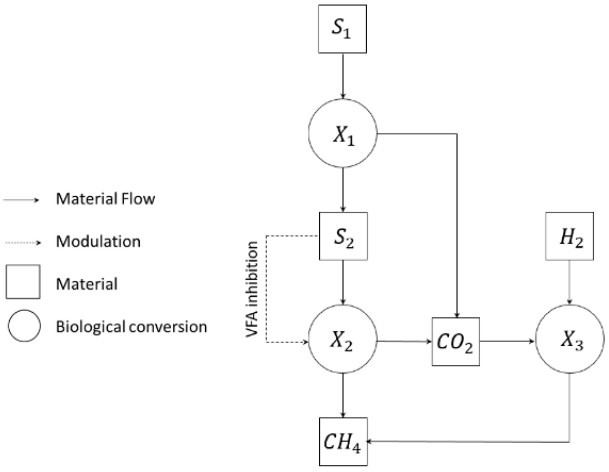
Figure 2. Outline of the biogas model.